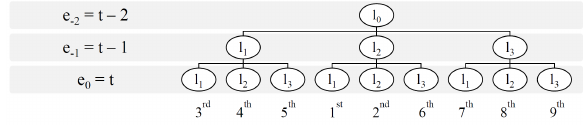
Figure 5. Path Assessment example in a tree format The discrete locations of the highest ranked path are chosen as